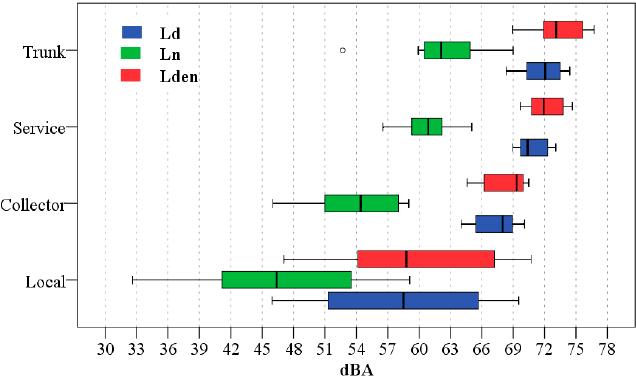
Figure 3. Box plot of L d , L n and L den descriptors registered in each road types. Table 2. p -Values with Holm adjustment of pairwise comparisons of road types using Mann-Whitney U test.